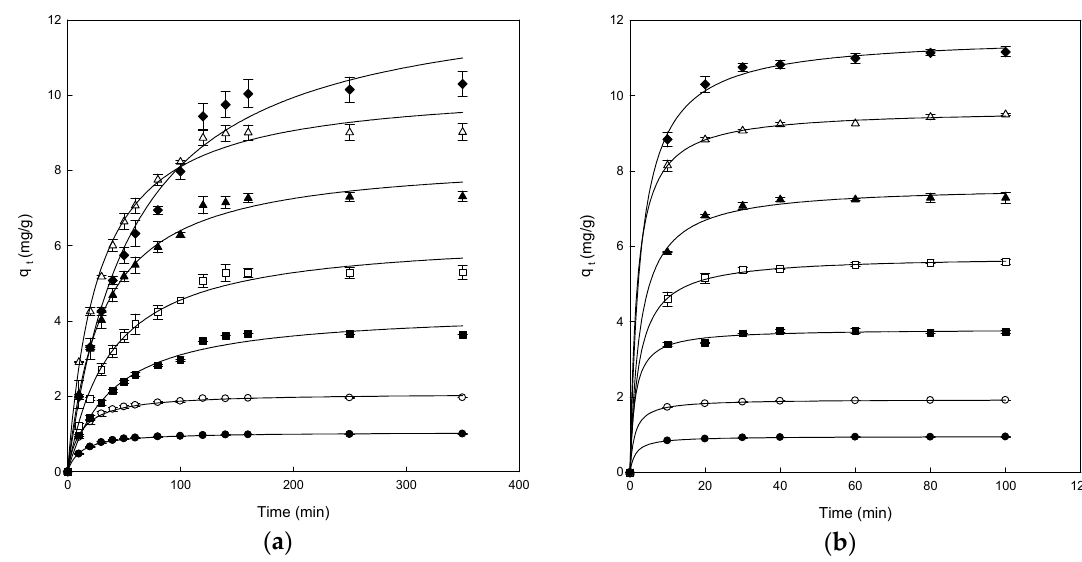
Figure 3. The e ff ect of contact time between chitosan-NaOH ( a ) and β -CDs-EPI ( b ) at di ff erent Figure 3. The effect of contact time between chitosan-NaOH ( a ) and β -CDs-EPI ( b ) at different concentrations of Direct Blue 78 25 mg / L ( (cid:8) ), 50 mg / L ( ), 100 mg / L ( (cid:4) ), 150 mg / L ( (cid:3) ), 200 mg / L ( (cid:78) ), concentrations of Direct Blue 78 25 mg/L ( ● ), 50 mg/L ( ○ ), 100 mg/L ( ■ ), 150 mg/L ( □ ), 200 mg/L ( ▲ ), (cid:35) 250 mg / L ( ∆ ) and 300 mg / L ( (cid:7) ). The curves were adjusted using a hyperbolic mathematical 250 mg/L ( Δ ) and 300 mg/L ( ♦ ). The curves were adjusted using a hyperbolic mathematical model.